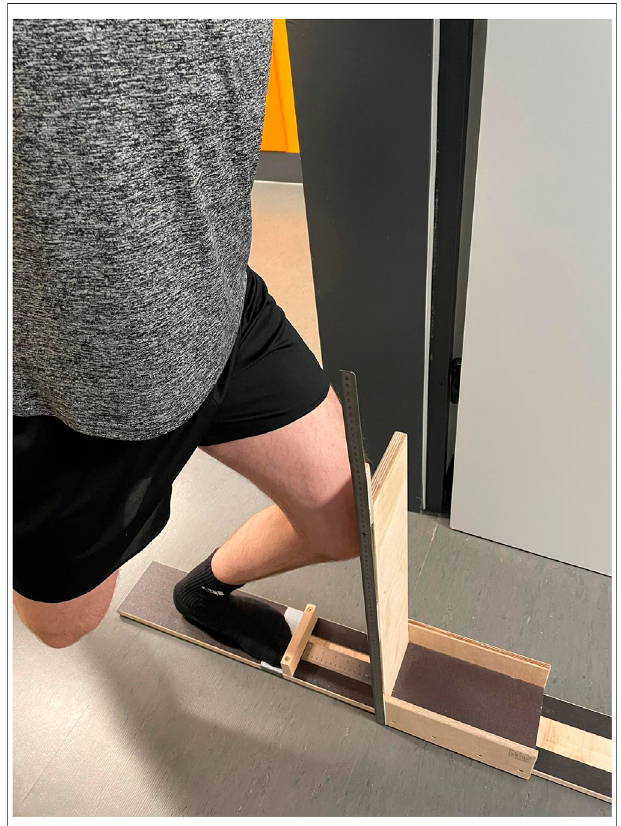
FIGURE 4 | Sliding device for the KtW to evaluate fl exibility in the ankle.